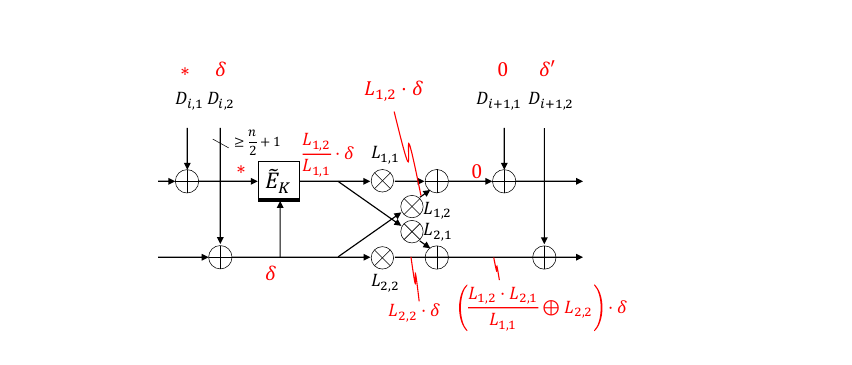
. Considering that 2